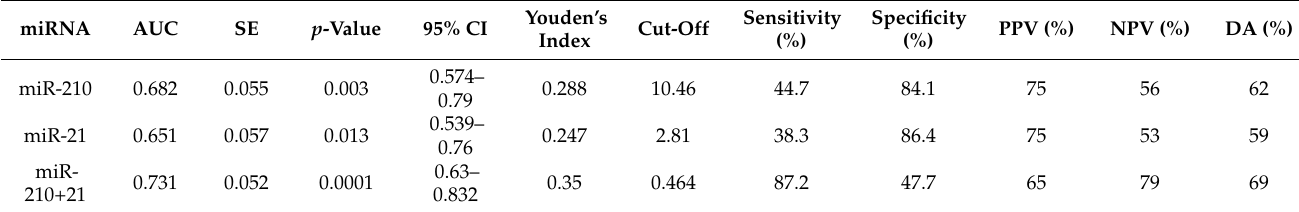
Table 2. Diagnostic parameters to evaluate individual and combined miRNA for diagnosis of CRC patients. AUC: area under the curve, SE: standard error of mean, PPV: positive predicted value, NPV: negative predicted value, and DA: diagnostic